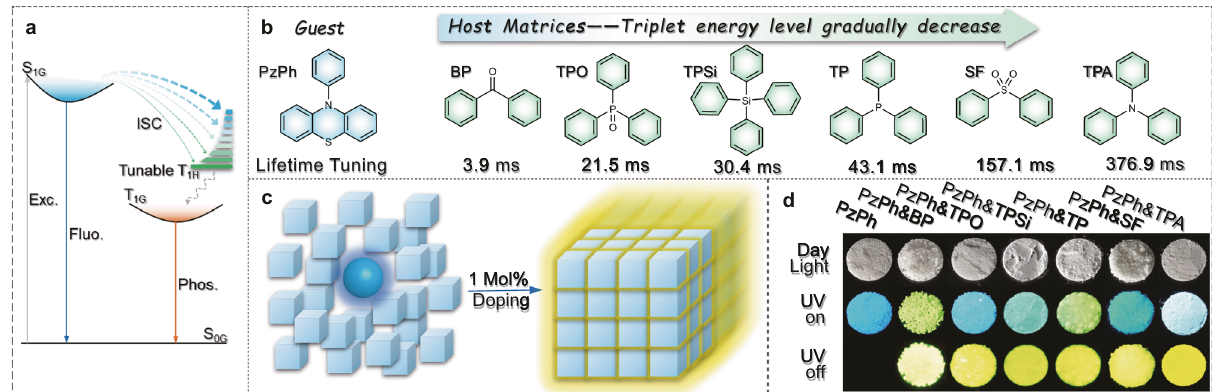
Fig. 1 Design and fabrication of mH/G UOP system. a Jablonski diagram for ISC and energy transfer pathways between host and guest species of the lifetime-tunable mH/G UOP system (Exc., Fluo., and Phos. are referred to Excitation, Fluorescence, and Phosphorescence). b chemical structures of the guest emitter PzPh and host matrices (BP, TPO, TPSi, TP, SF, and TPA) and lifetimes of the mH/G UOP system. c Schematic illustration of mH/G doping strategy. d Photographs of PzPh and mH/G UOP materials at the conditions of “ Daylight ” , “ UV on (365 nm) ” and “ UV off ” .